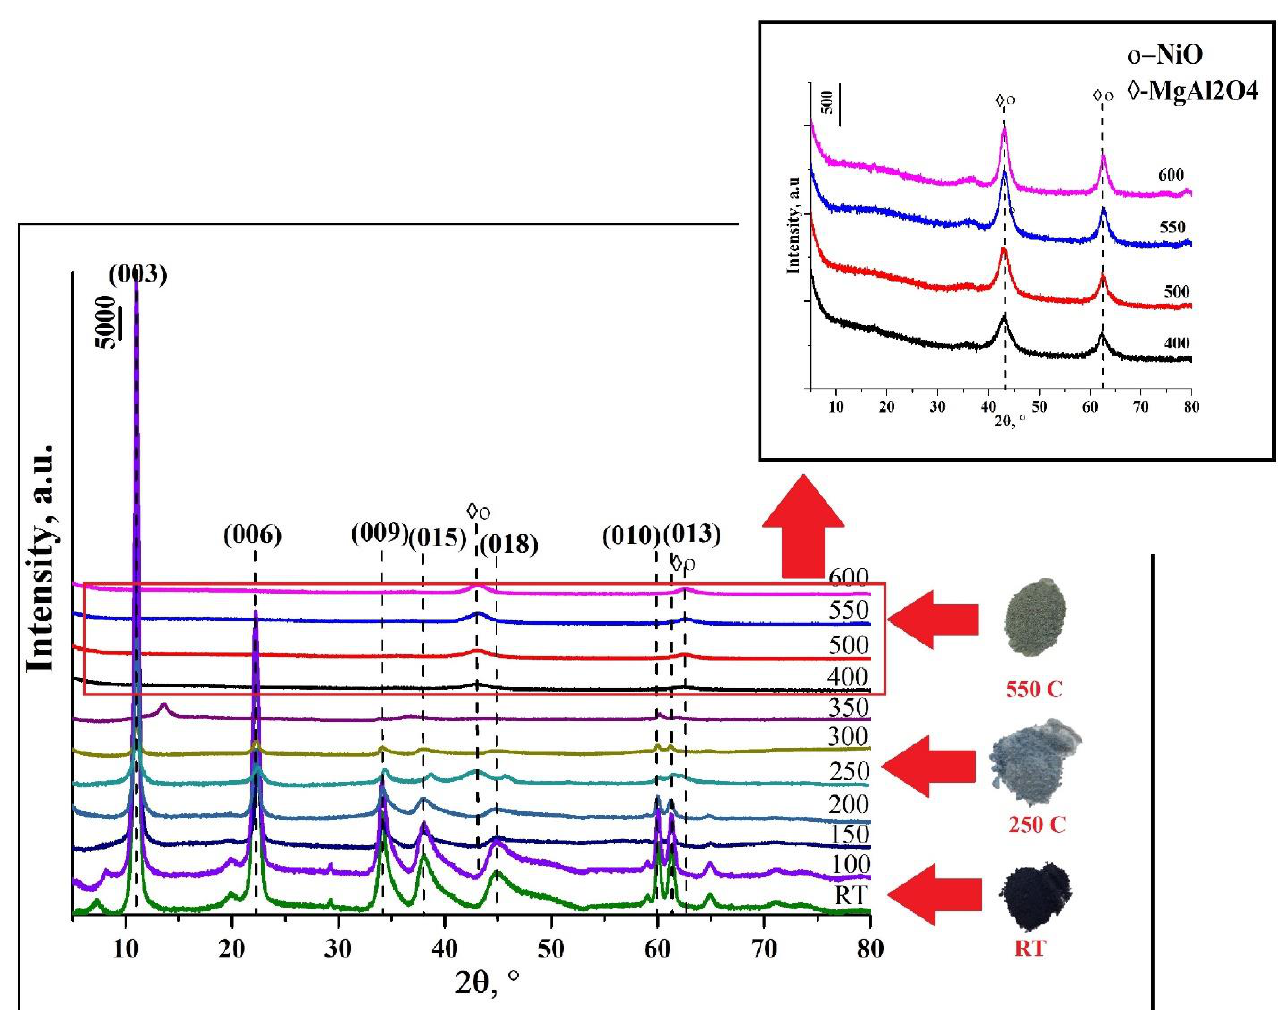
Figure 6. Powder XRD patterns of Mg/AlNi-25-c calcined at different temperatures .